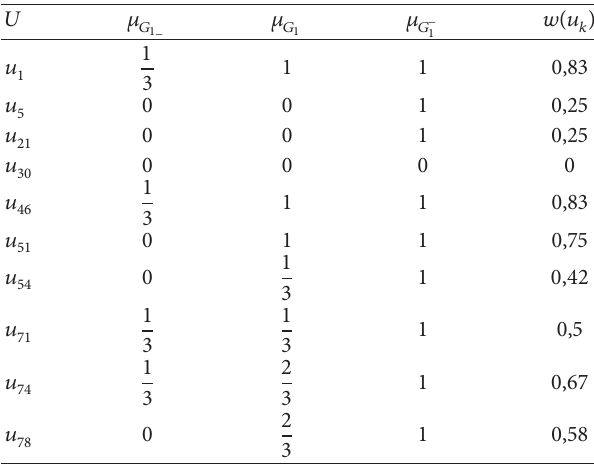
Table 4: Tabular presentation of the fuzzy soft set 𝐺 𝐹 = (𝛼,𝐶) with weighted evaluation value of several